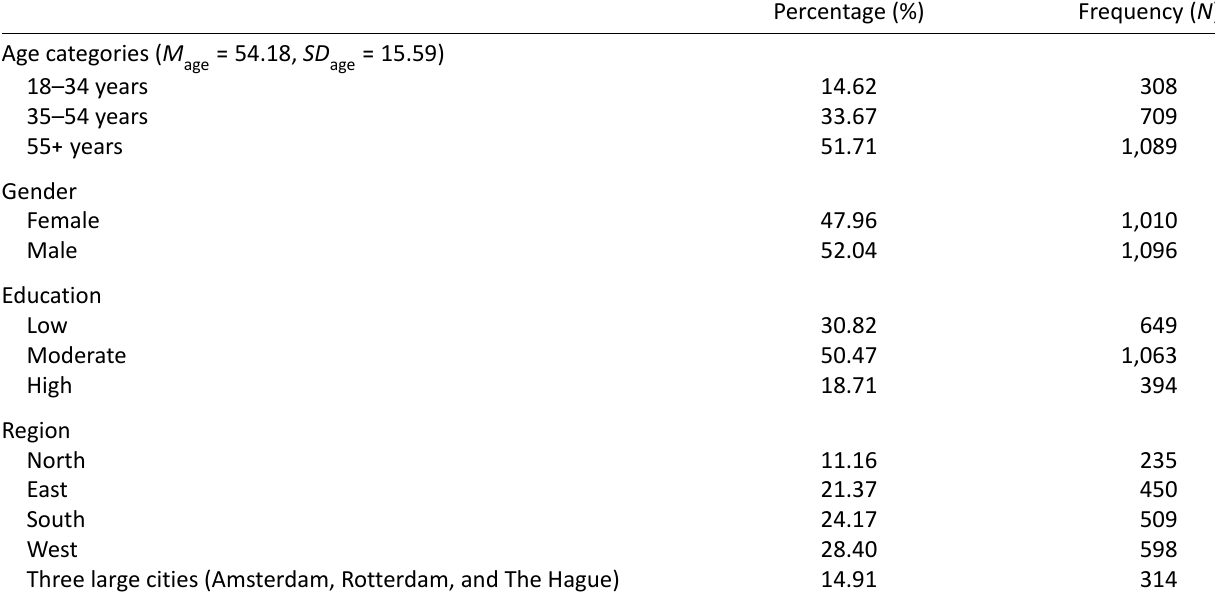
Table 1. Socio‐demographic characteristics of the representative Dutch